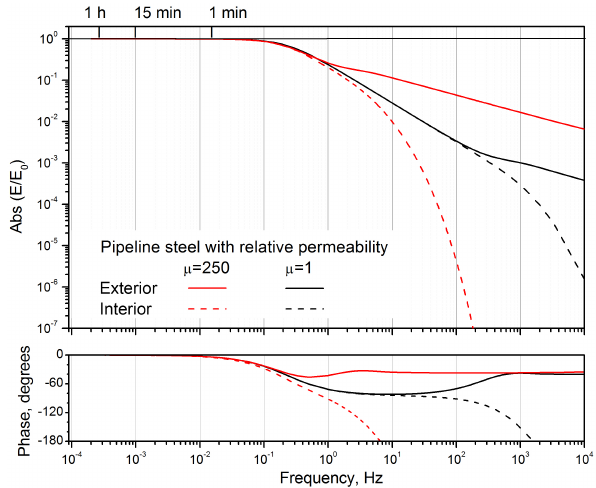
Figure 5. The frequency dependencies of normalized absolute am- plitude (top) and phase (bottom) of the electric field at the outer surface and near the centre of the steel in pipeline with relative per- meabilities of 1 (black lines) and 250 (red lines), embedded in soil with conductivity 10 − 3 Sm − 1